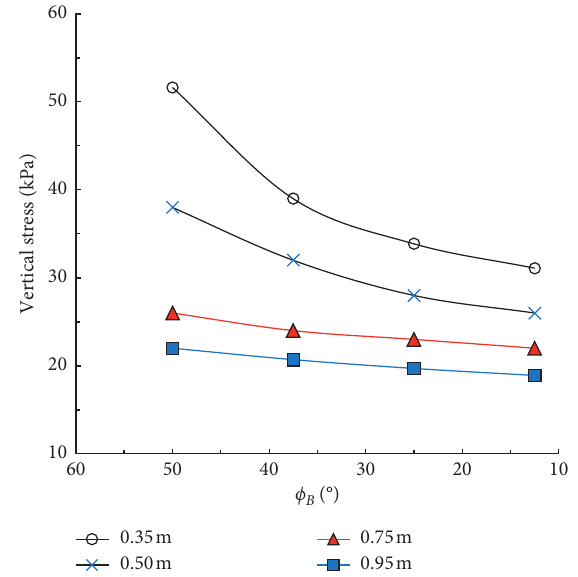
Figure 9: Maximum vertical stress in subgrade with different friction angles of ballast.